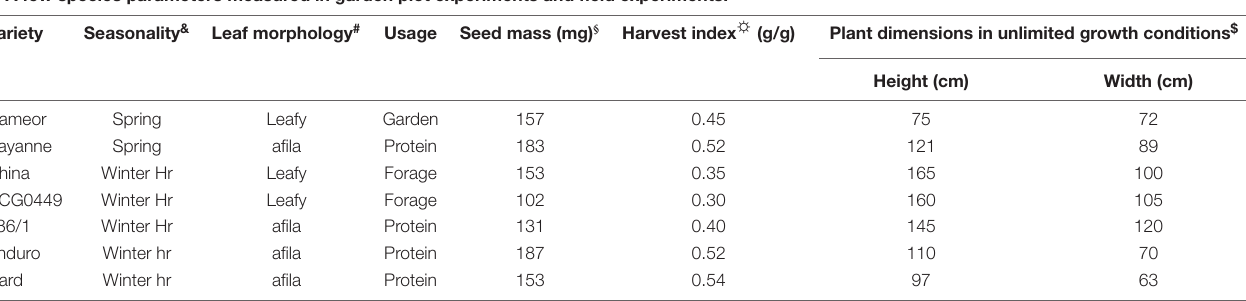
TABLE 1 | List of pea ( Pisum sativum L.) varieties tested in the present experiments. A. A few species parameters measured in garden plot experiments and field